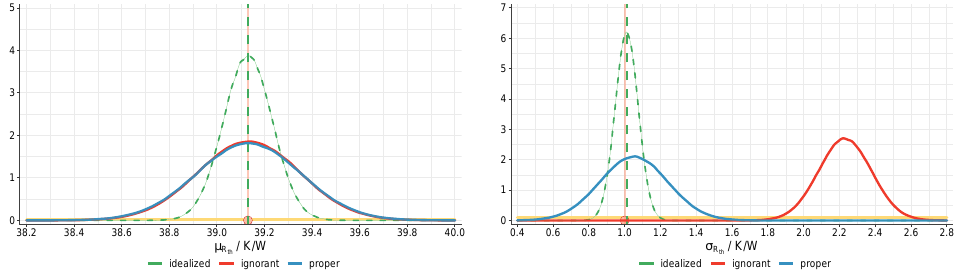
Figure 10. Visualization of Table 2: Distribution of posterior means for ( left ) µ R ( right ) σ R over 100 datasets (E3.a–E3.c) under different strategies, true values (red circle) and th (uniform) prior distributions (yellow line).